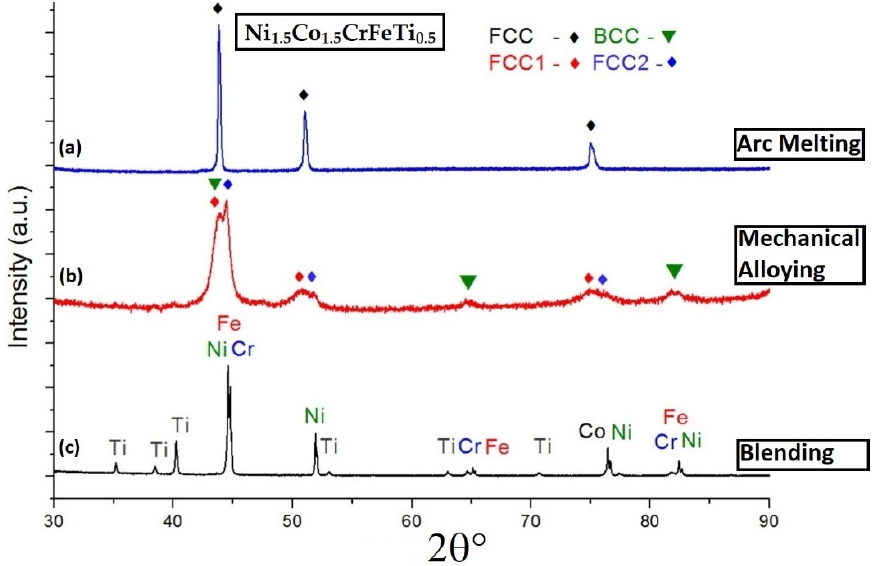
Figure 14. XRD patterns of ( a ) blended powder feedstock, ( b ) mechanical alloyed powder, ( c ) Spark Plasma Sintering (SPS) compacted alloyed powder. Reprinted with permission from [141] Copyright 2020.